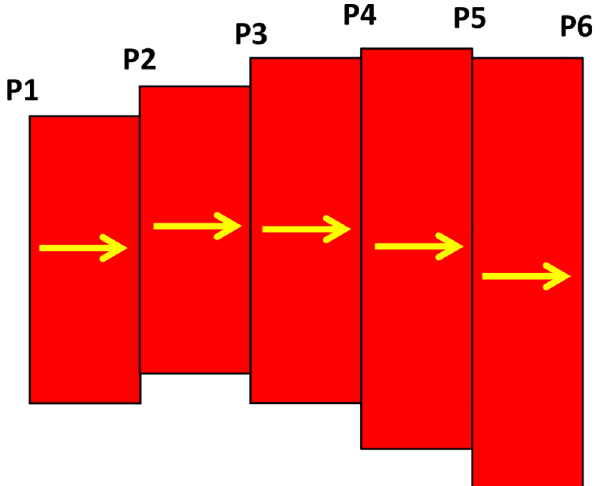
Fig 7. Few segments of a vessel from the